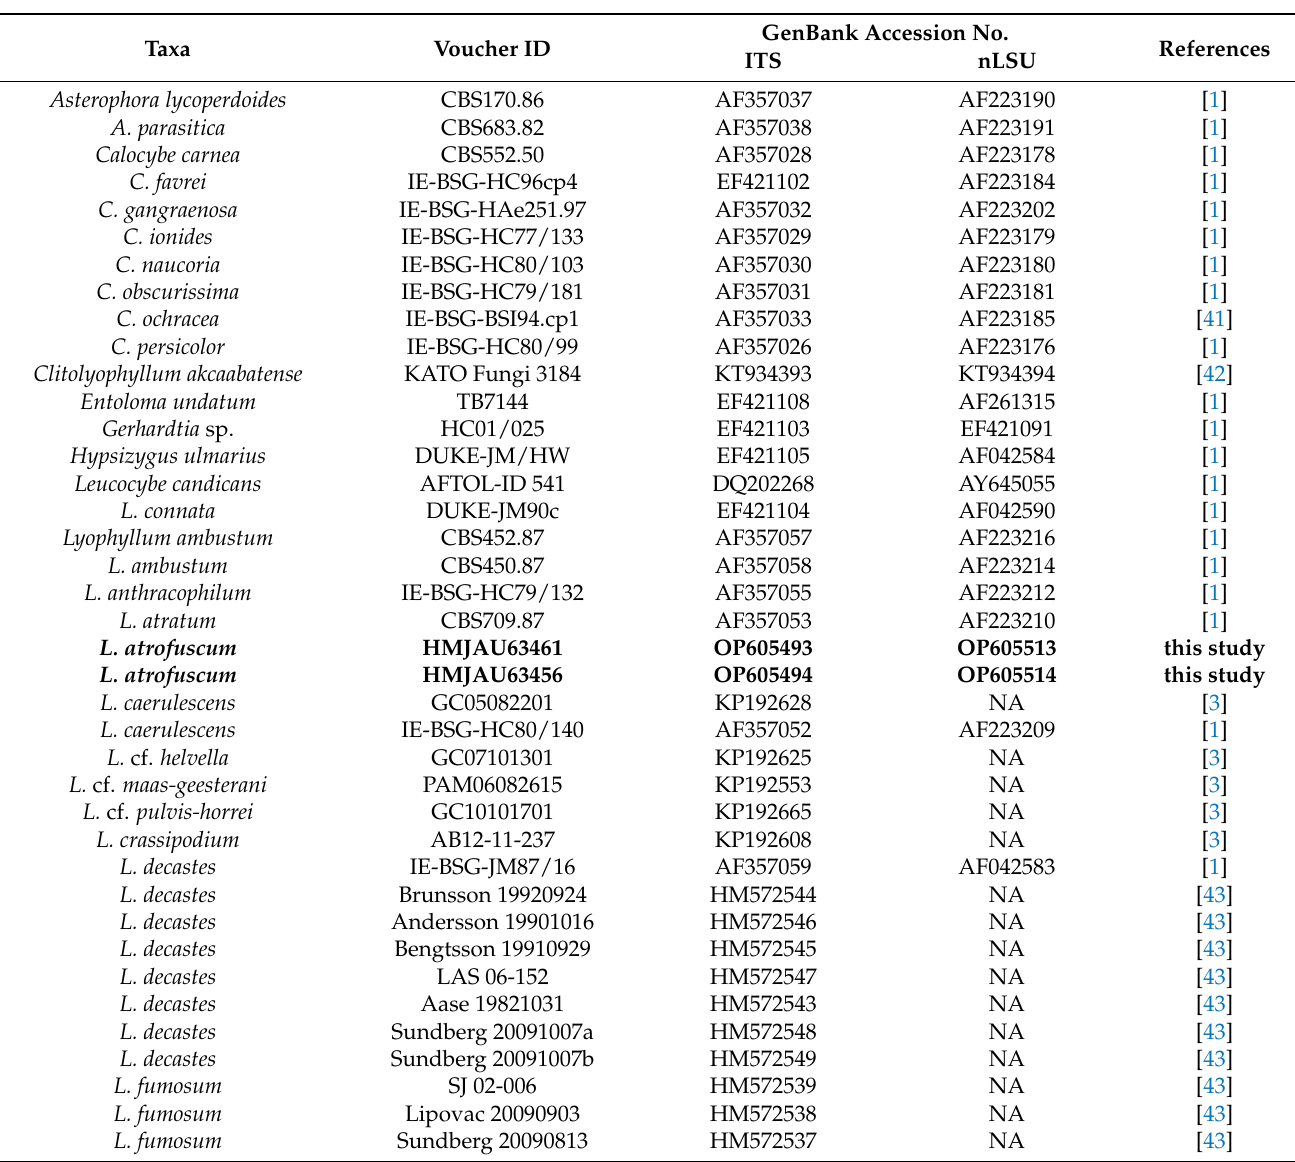
Table 1. Taxa information and GenBank accession numbers of the sequences used in this